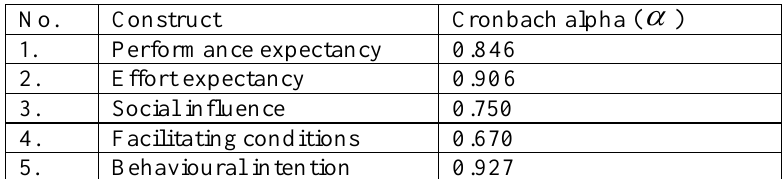
Table 2 Cronbach's Alpha Coefficients for Construct Reliability